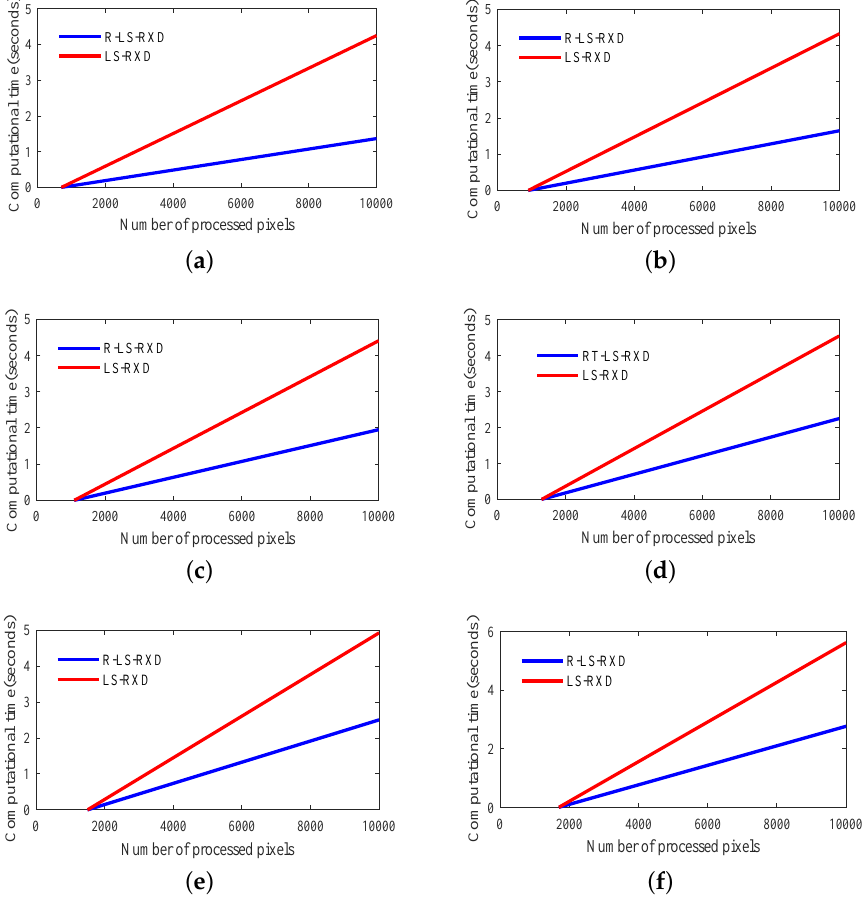
Figure 14. Plots of computing time versus number of processed pixels. ( a ) ω =7; ( b ) ω =9; ( c ) ω =11; ( d ) ω =13; ( e ) ω =15; ( f ) ω